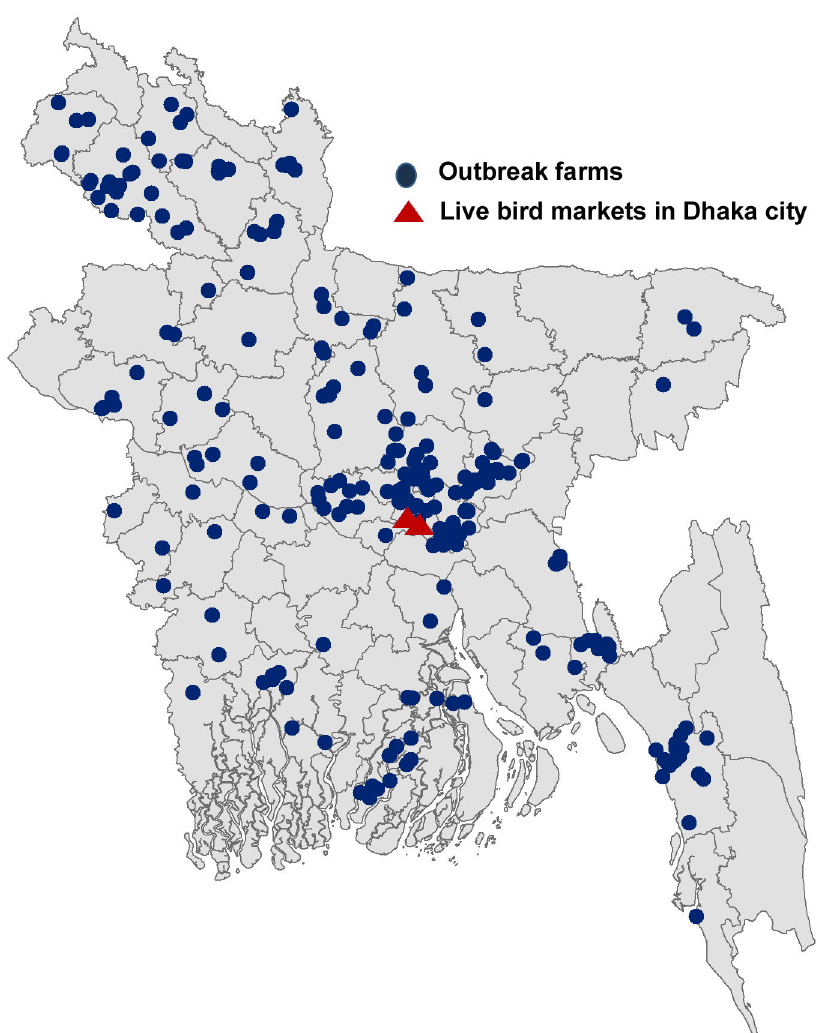
Figure 1. Location of confirmed HPAI H5N1 virus poultry farm outbreaks during December 2007-June 2009 and suspected HPAI H5N1 outbreaks in live bird markets in 2009,